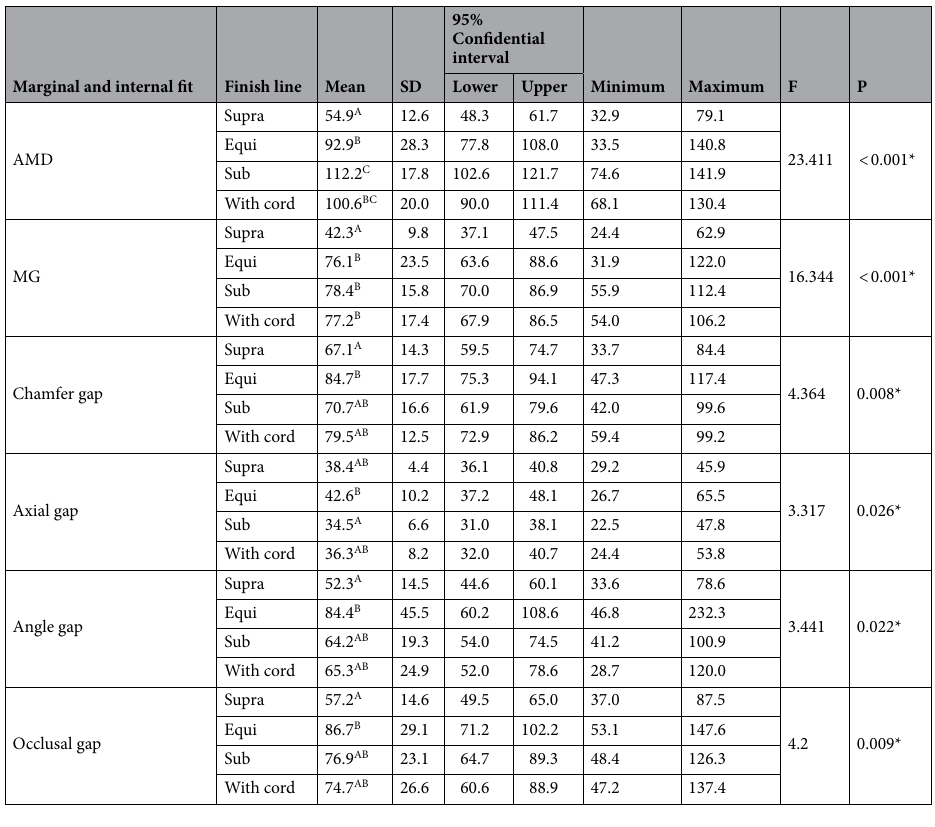
Table 1. Comparison of marginal and internal fit according to finish line locations. AMD absolute marginal discrepancy, MG marginal gap. *Significance determined by one-way ANOVA, P < 0.05. Different letters indicate significant differences among finish line locations by Tukey HSD test, P < 0.05.